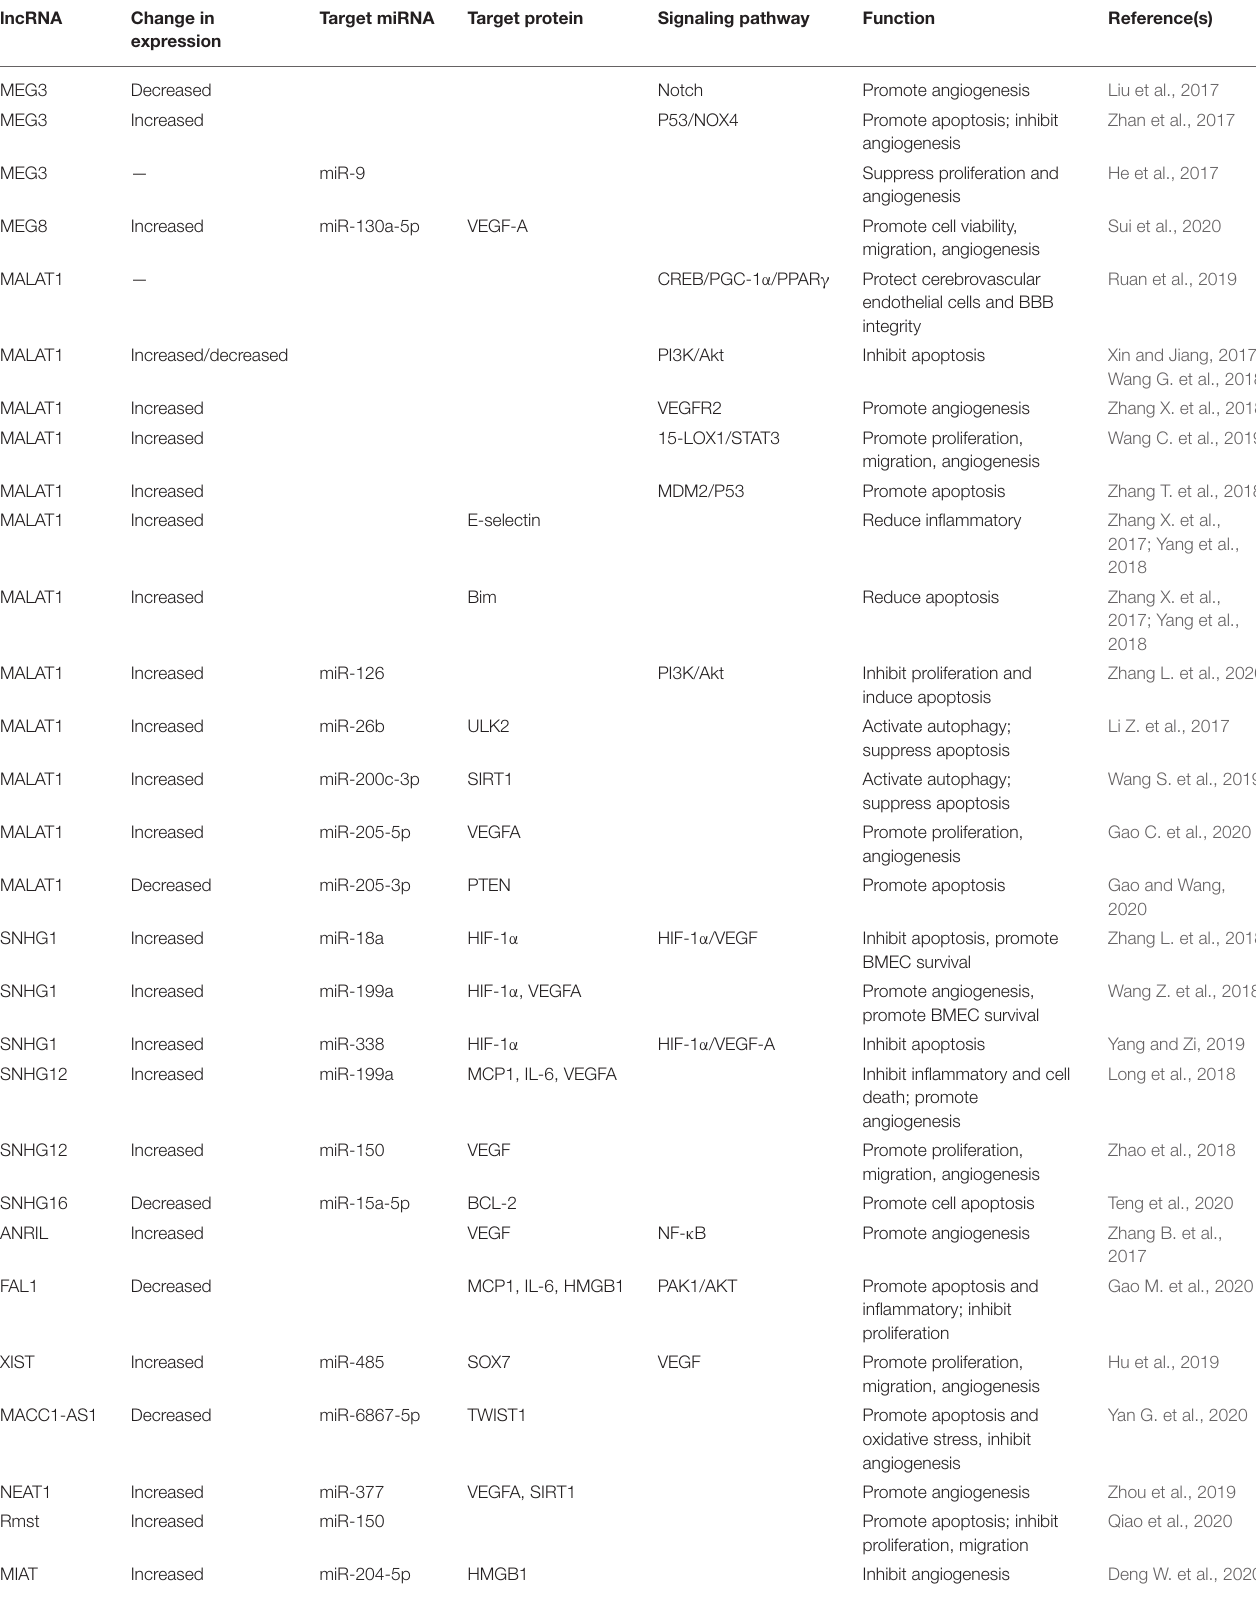
TABLE 1 | The roles of lncRNAs on angiogenesis in ischemic stroke.